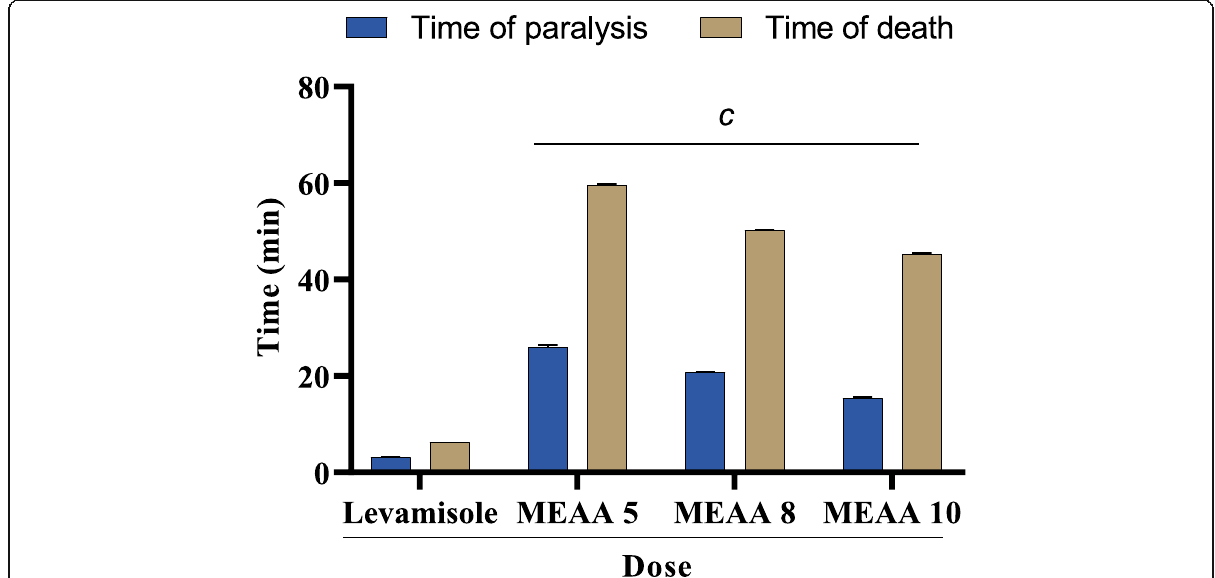
Fig. 4 Anthelmintic activity of methanol leaves extract of A . auriculiformis (MEAA). Values are represented in Mean ± SEM ( n = 3). c p < 0.001 statistically significant compared to levamisole followed by one-way ANOVA ( t test)